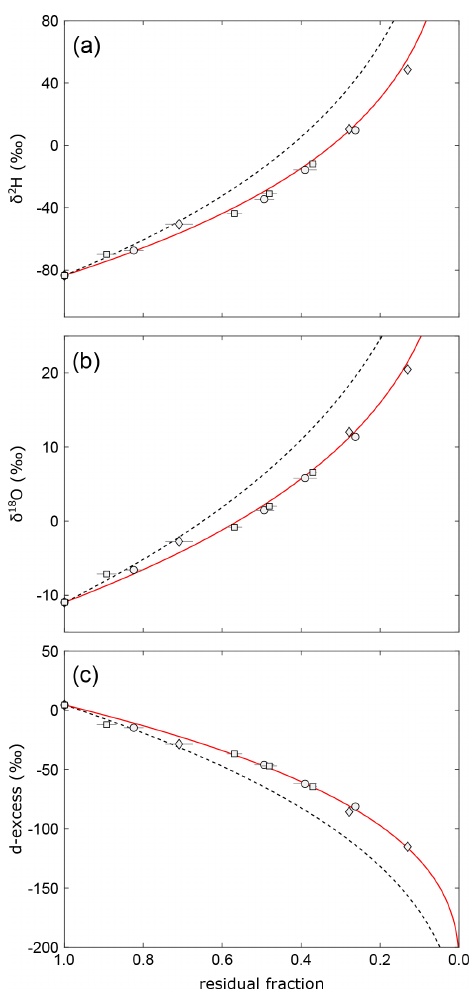
Figure 8. Evolution of (a) δ 2 H, (b) δ 18 O, and (c) d-excess of re- maining water in the evaporation experiments. The solid lines show evaporation trajectories obtained by fitting the simple evaporation model independently to δ 18 O ( n = 0 . 34), δ 2 H ( n = 0), and d-excess ( n = 0 . 44) vs. residual fraction. Note that the δ 2 H data cannot be fitted for any reasonable turbulence coefficient. The dashed lines in (a) and (b) are evaporation trajectories modelled using the same turbulence coefficient as for the d-excess data.